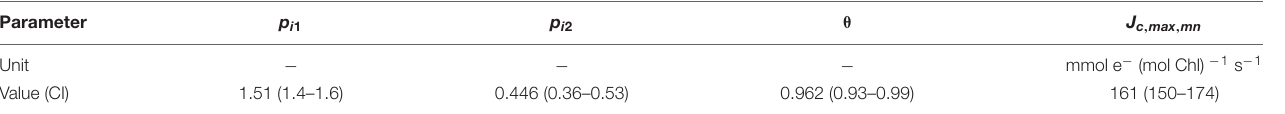
TABLE 2 | Parameter estimates for the fit of Equation 6 to electron transport rate of differently light acclimated cucumber leaves. Parameter